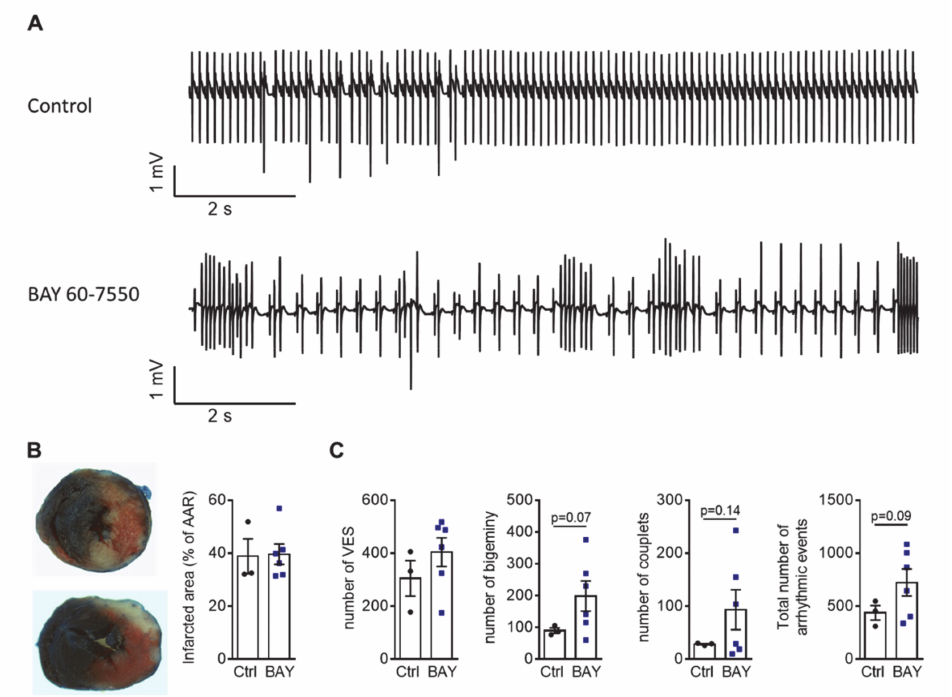
Figure 6. Specific PDE2 inhibition tends to increase the number of total arrhythmic events in ex vivo perfused hearts after reperfusion injury. ( A ) Representative traces of ECG recordings after reperfusion injury with 30 min of LAD ligation in ex vivo perfused hearts with and without PDE2 inhibitor BAY 60-7550 (BAY, 100 nM). ( B ) Evans blue and TTC staining of heart slices after reperfusion injury and quantification of infarcted area at risk (AAR, %). ( C ) Quantification of ventricular extrasystoles (VES), bigeminy, couplets and total number of arrhythmic events. Statistical p -values vs. Ctrl as indicated (N = 3–6